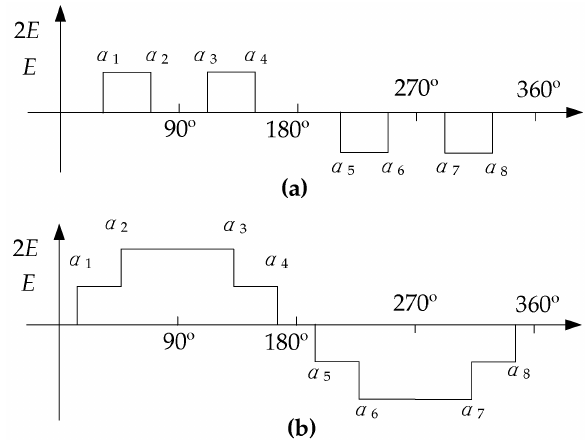
Figure 2. Pulse width modulation (PWM) waveforms definition of two switching angles according to the quarter-wave SHEPWM techniques. ( a ) Waveform at low modulation width; ( b ) waveform at high modulation